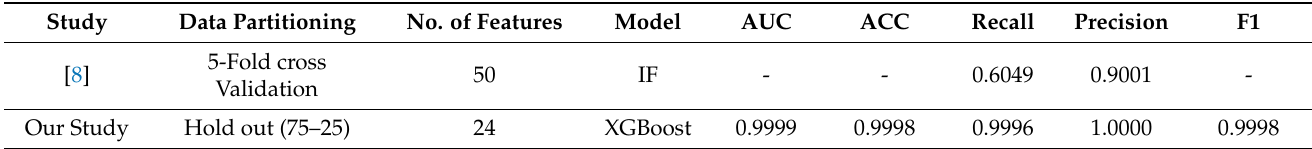
Table 10. Comparison of the proposed work with the benchmark study.